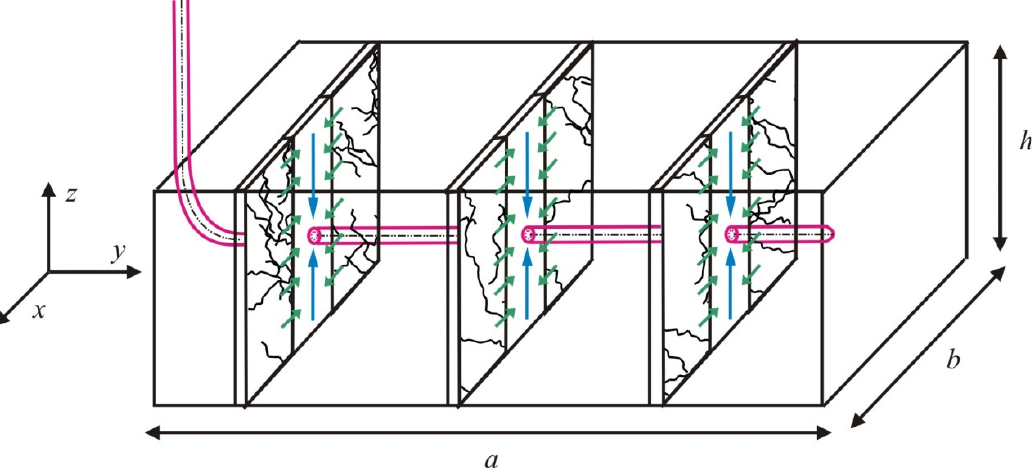
Figure 1. Physical model of two-phase seepage flow in shale gas fractured horizontal wells. (1) The shale reservoir is a dual-medium reservoir, and the fluid flow in the reservoir includes the matrix desorption and diffusion and the fracture Darcy